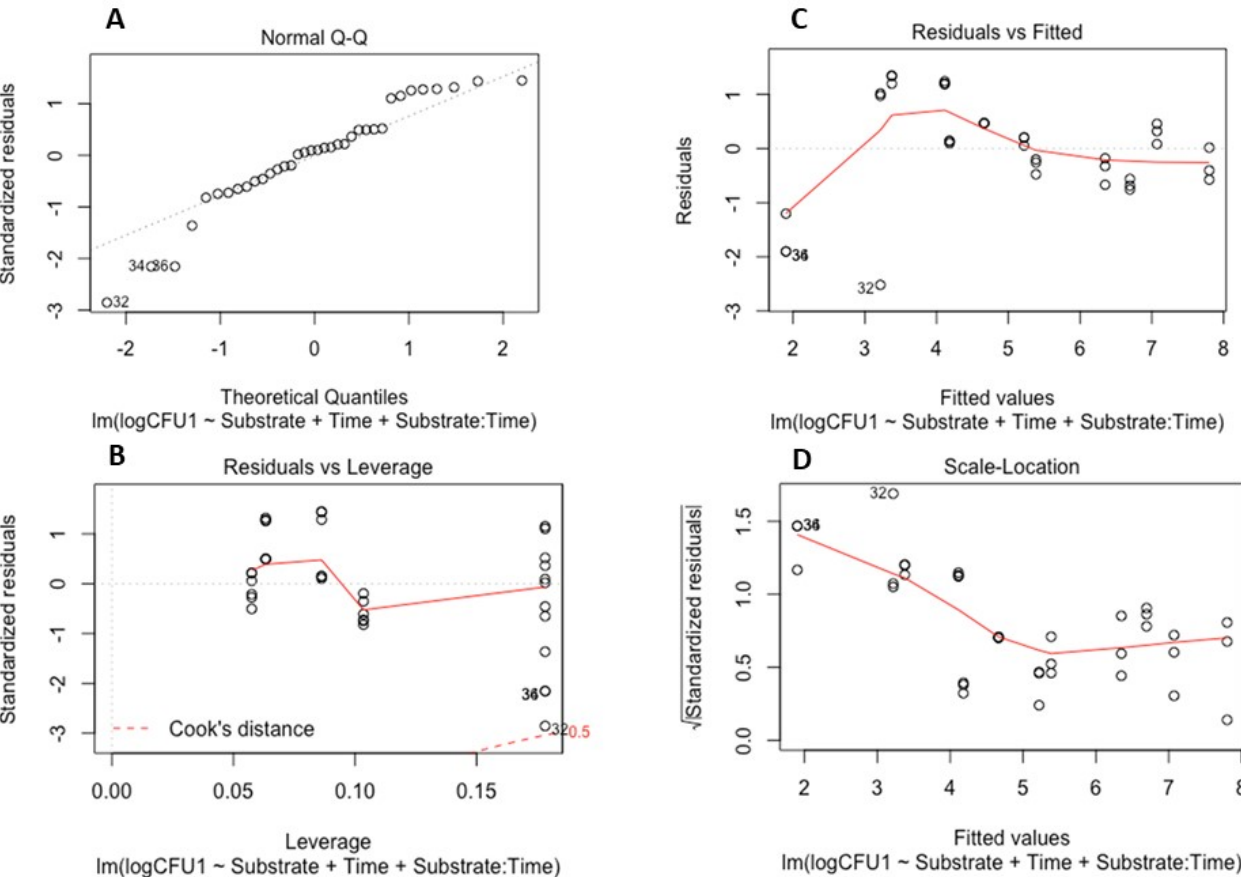
Figure 3. Model validation for survival of Phytophthora cryptogea : ( A ) Q-Q plot of standardized residuals against fitted values of the model; ( B ) residuals versus leverage values; ( C ) residuals versus fitted values plot; ( D ) scale location of residual values plot.